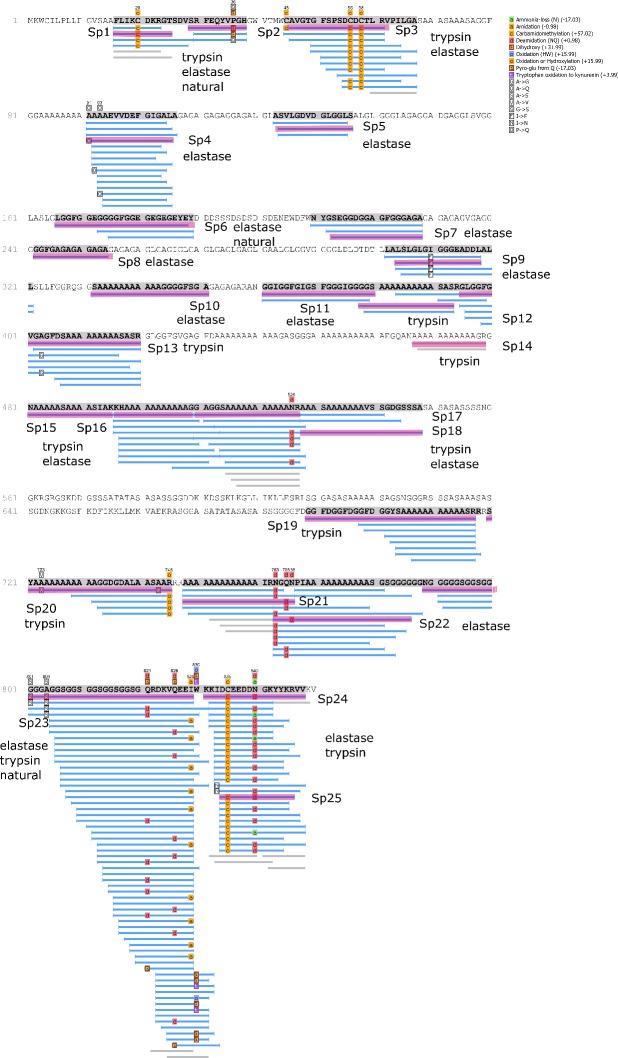
Protein Hic74 identified in Unio pictorum: sequence coverage, highlighting in pink the product ion spectra ('Sp') shown below.Sequences reconstructed by assisted de novo on the basis of mono-charged ions mainly (spectra were acquired on the 400-1600 m/z range and multiply-charged ions were detected).